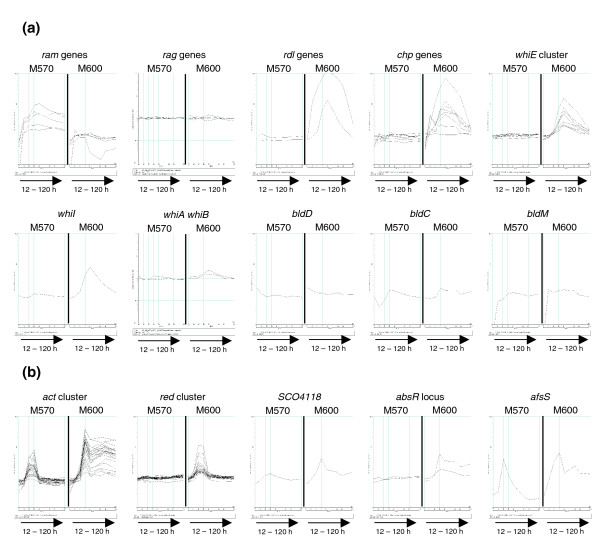
Transcription profiles of genes associated with (a) morphological differentiation, and (b) pigmented antibiotic production that were significantly differently expressed between strain M600 (relA+ ppGpp+) and M570 (relA- ppGpp-). In each panel, the x-axis represents culture age, and the y-axis is normalized transcript abundance in log10 scale.